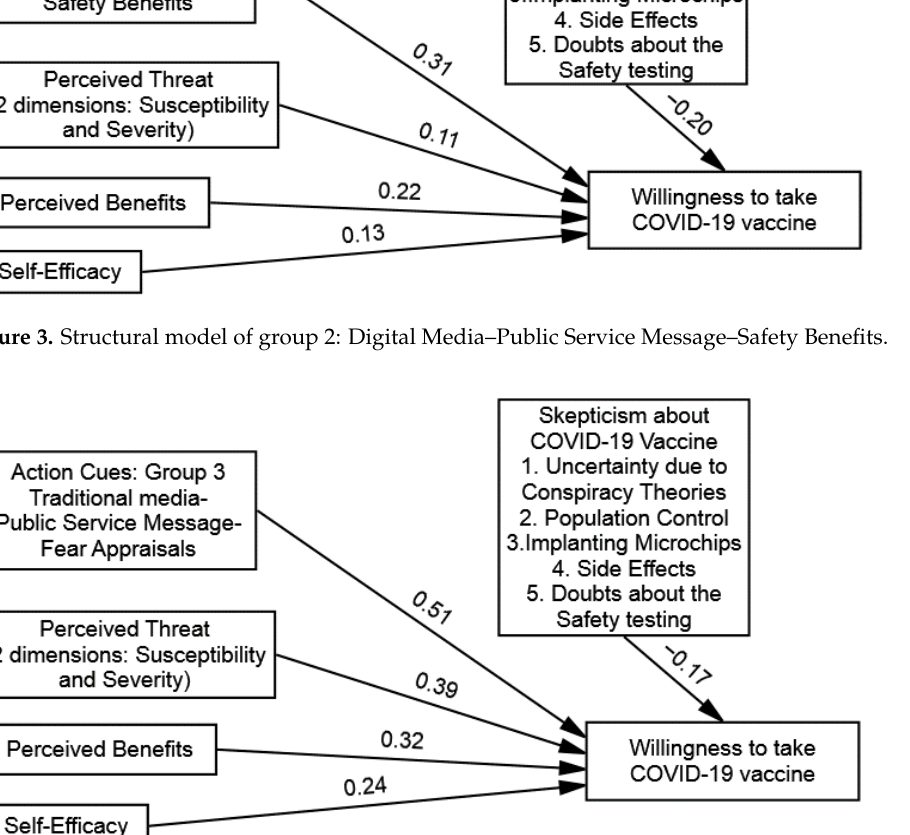
Figure 5. Structural model of group 4: Digital Media–Public Service Message–Fear Appraisals. Table 5. Hypothesis Testing. Direct Influence